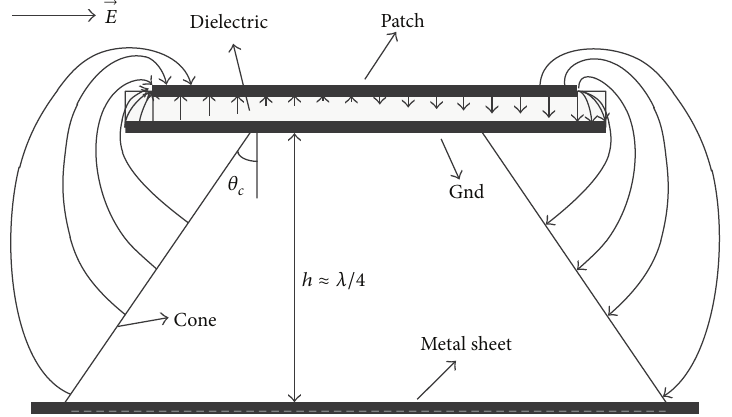
Figure 2: The electric field distribution